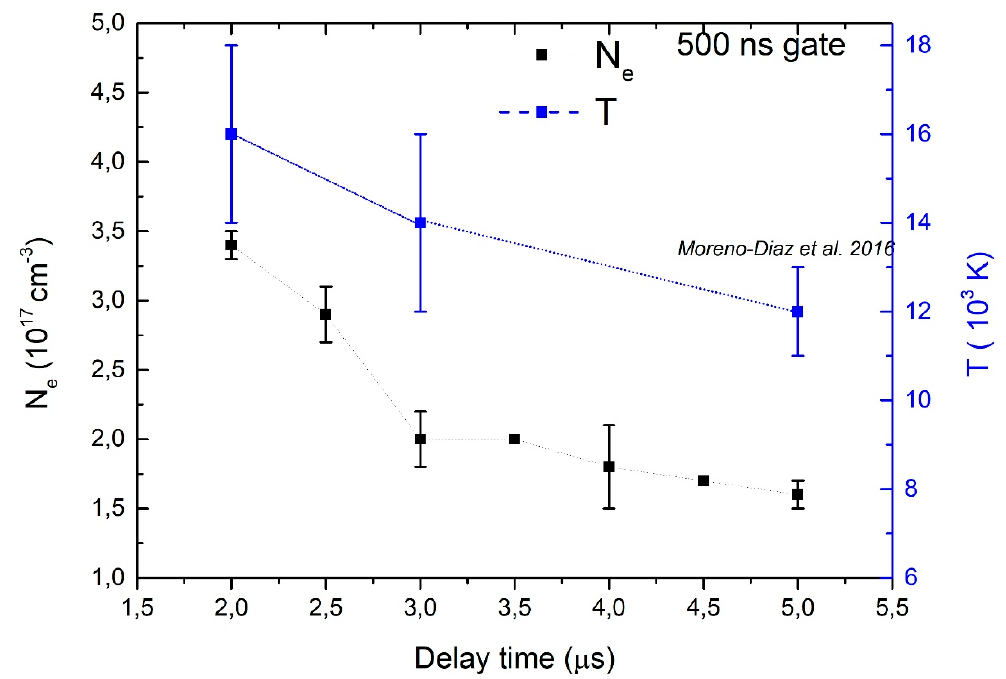
Figure 8. Electron density and electronic temperature versus delay time obtained with a gate time of 500 ns.